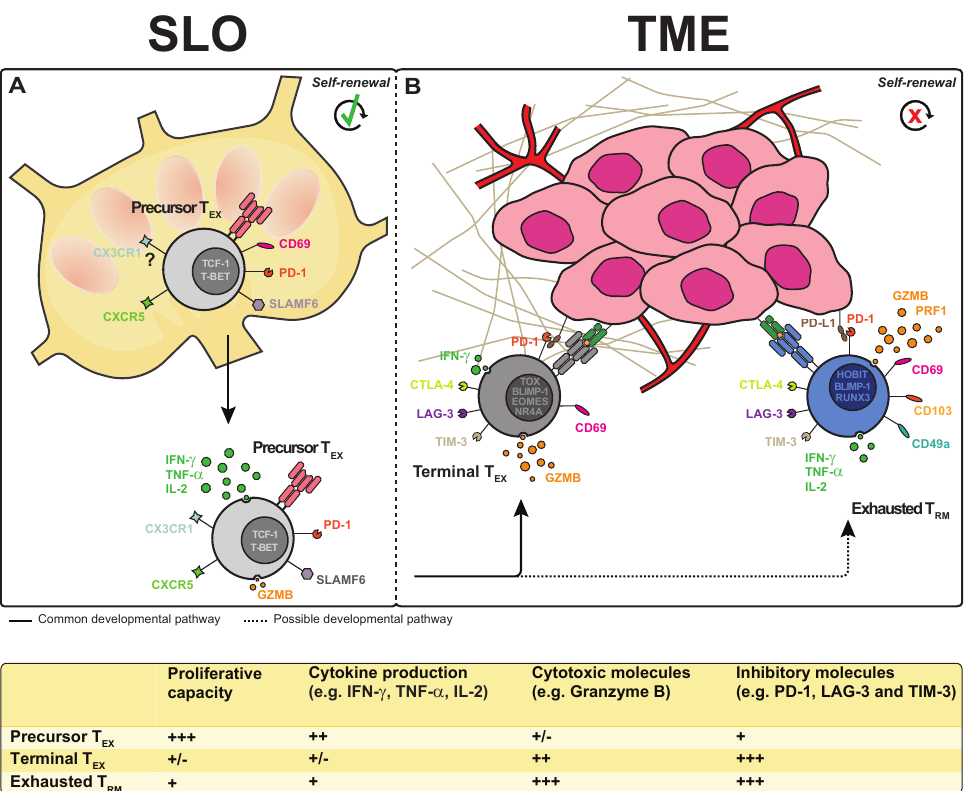
Figure 1. The differentiation pathway of exhausted T cells and tissue-resident memory T cells in the tumor microenvironment.